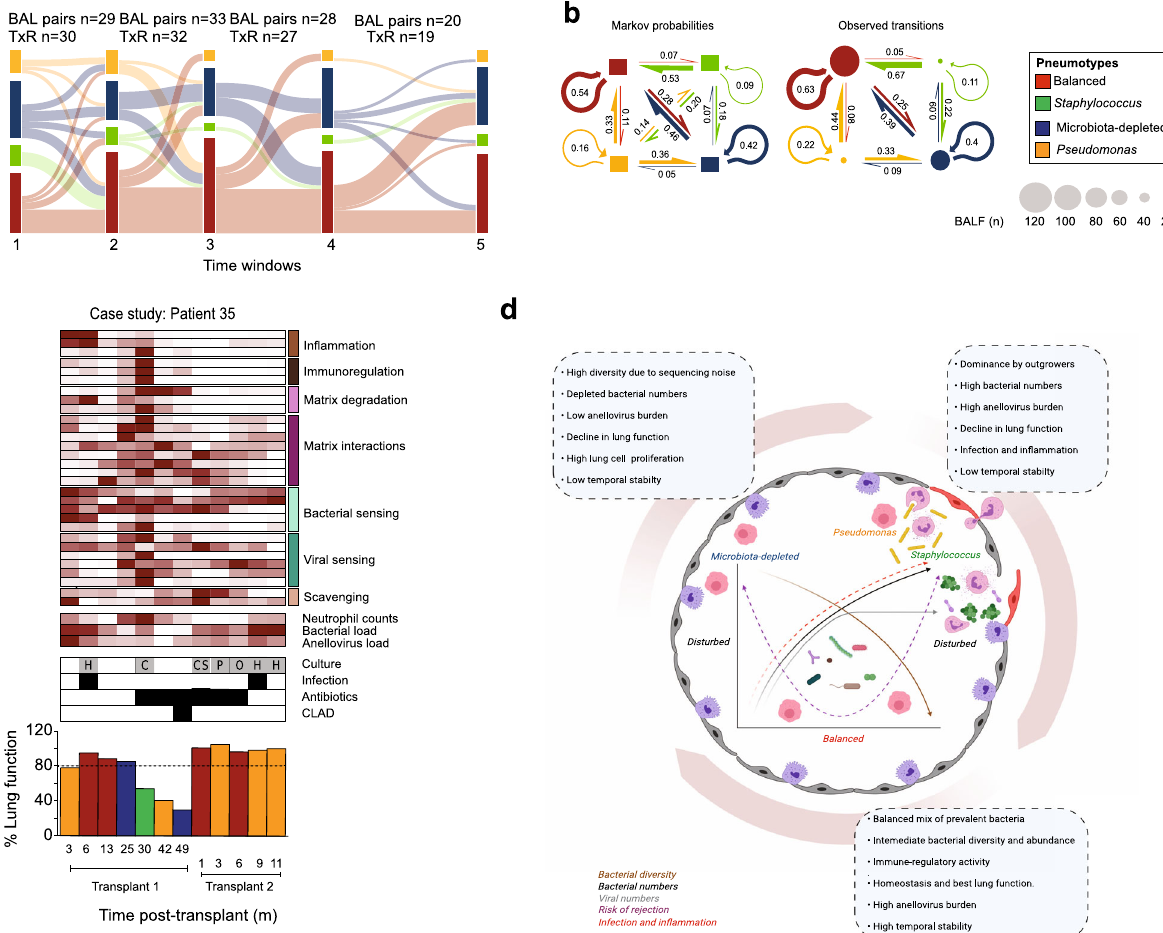
Fig. 7 Longitudinal analysis of lung microbiota post-transplant and dynamics of pneumotype transitions. a Sankey diagram showing transition of paired samples between pneumotypes (colors) across fi ve time windows. b Markov chain model (See Methods) fi tted to the observed pneumotype transitions ( n = size of circle). Model was initiated with equal probabilities for each pneumotype (0.25, 100 bootstraps, left panel) and given transition matrix. Pneumotypes are represented by colored arrows/boxes, and the direction of a transition is indicated by a colored arrow of a thickness denoting the probability. c A patient case study showing transition of pneumotypes with clinical characteristics across two transplantation events. The heatmap shows host gene expression with functional categories (see also Fig. 4a, right vertical colored bars), neutrophil counts, bacterial and anellovirus loads in BALF across time and pneumotypes. Taxa obtained in routine clinical culture were abbreviated with letters. Samples positive for infection, ongoing antibiotic treatment or CLAD (black boxes) are presented above bar plots showing % lung function (see also Fig. 6g), across transplantation events and time post- transplantation (months) and pneumotypes (bar colour). d Scheme of bimodal disruption in lung ecosystem (colored arrows in a x – y plot) leading either to (i) a microbiota-depleted pneumotype with ambigous bacterial diversity (brown), low counts of bacteria (black) and viruses (gray), high lung cellular proliferation and chronic decline in lung function leading to rejection (purple), or (ii) pneumotypes dominated by opportunistic pathogens ( Staphylococcus and Pseudomonas ) with loss in bacterial diversity, high infection rate and in fl ammation (red), acute decline in lung function and rejection. Best-case scenario is de fi ned by a middle ground with a balanced pneumotype consisting of the most prevalent bacteria in a homogenous composition with intermediate bacterial diversity, bacterial and viral abundance, high immune-modulatory activity and best preserved lung function. Original graphical art “ Created using BioRender.com ”